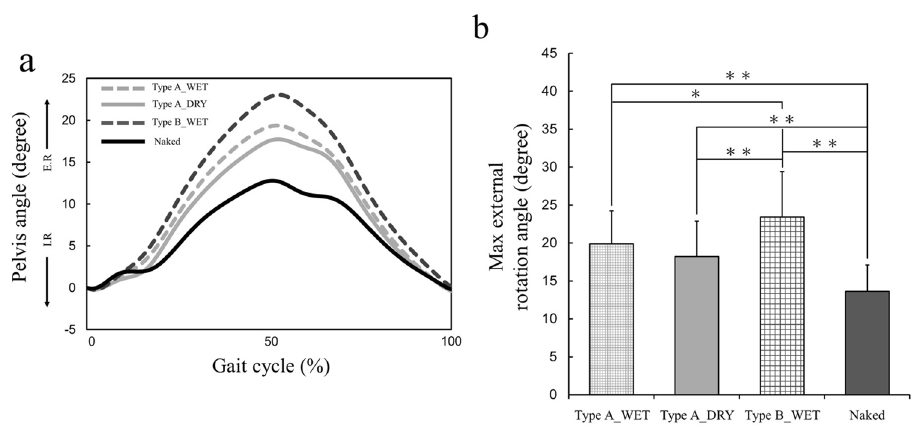
Figure 1. ( a ) Mean time series across subjects at each condition of the pelvic angle in the horizontal plane during a gait cycle. I.R. internal rotation, E.R. external rotation. ( b ) Mean and standard deviation of the mean of the normalized maximum external rotation angle on the pelvis for the four dress conditions. *p < 0.05; **p <